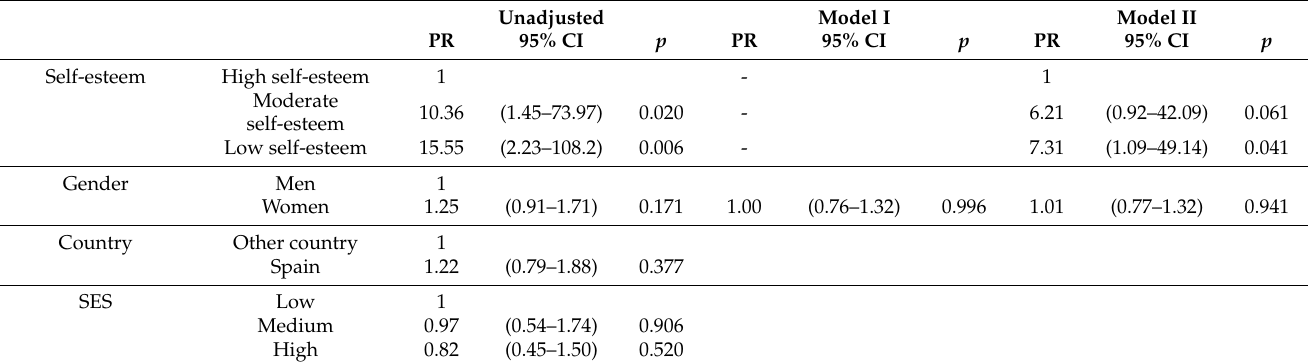
Table 4. Multivariate analysis of Poisson regression with robust variance for non-use of